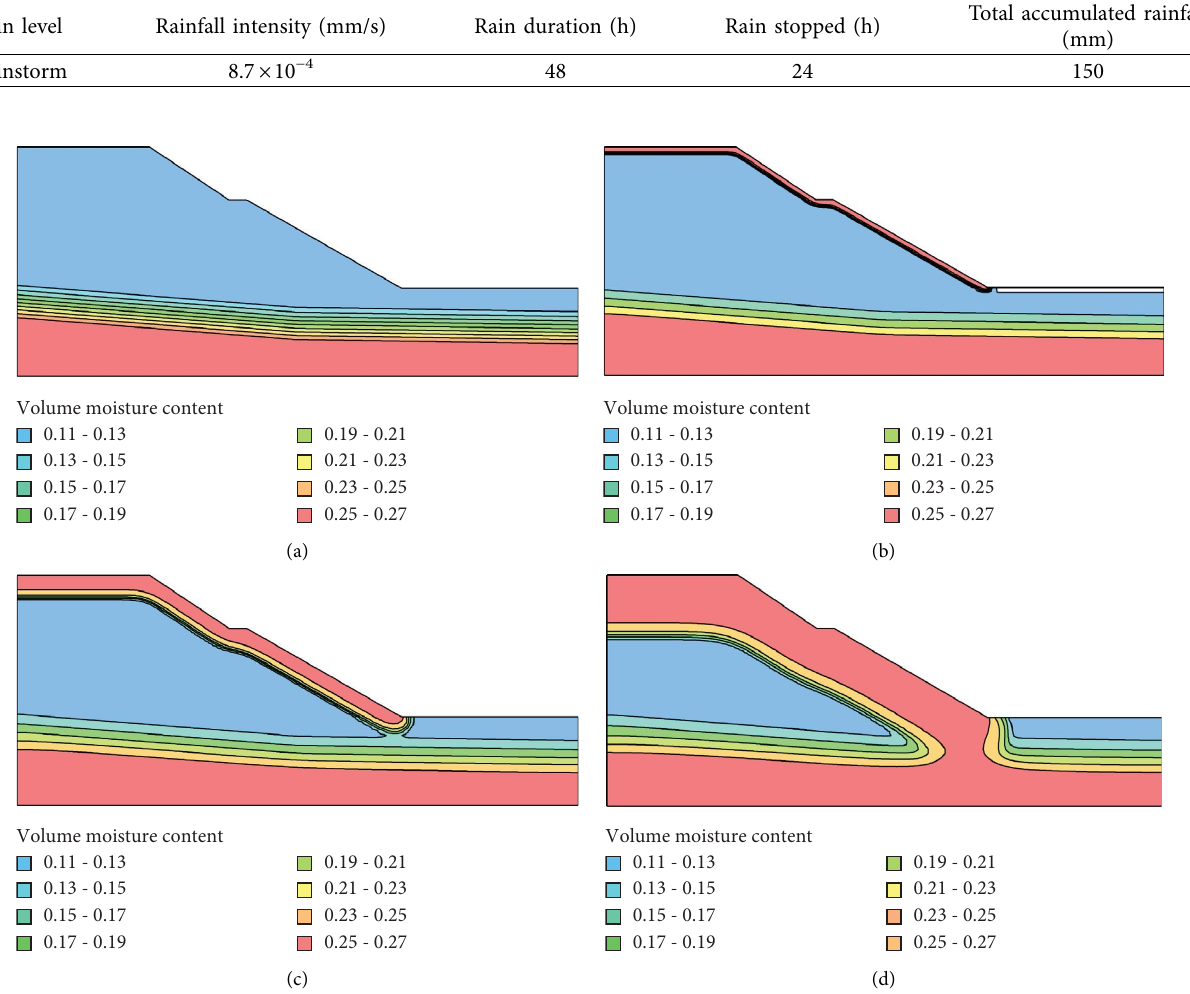
Table 2: Rain program.